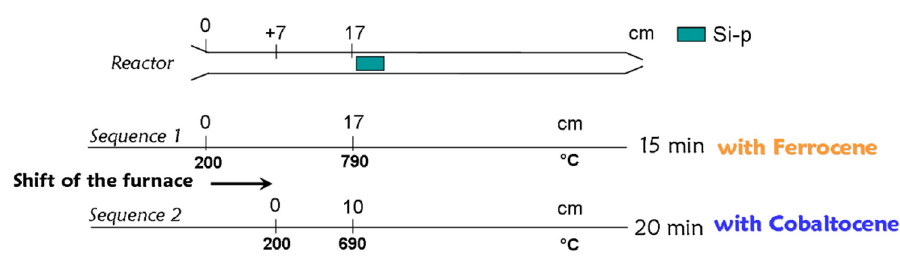
Figure 1. Chronology of sequences used in the bilayer synthesis with indication of substrate position in the furnace and duration for each injection sequence.